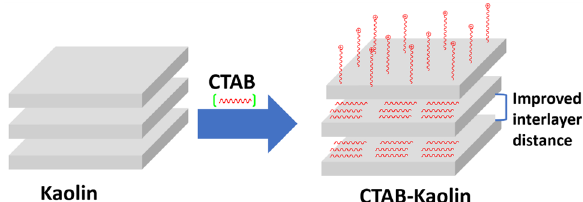
Fig. 1 Schematic diagram of the preparation of CTAB–kaolin